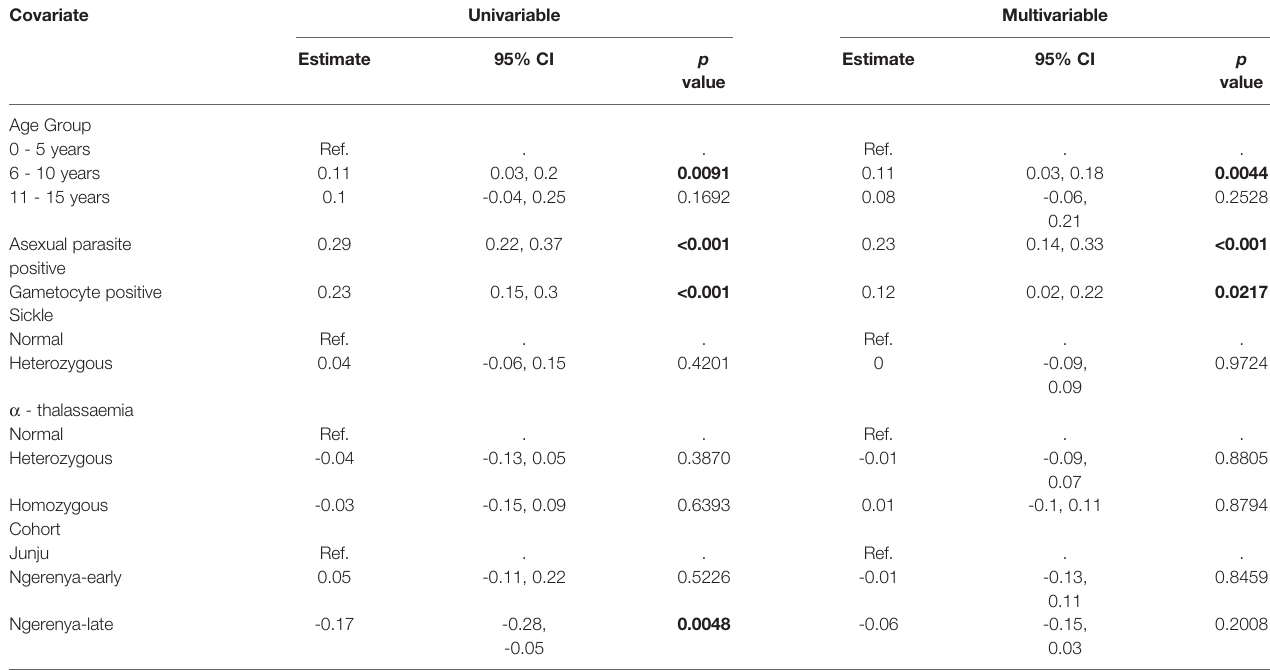
TABLE 5 | Linear regression analysis of the factors in fl uencing the number of antigens recognized by the study participants – KMLC cohort. Covariate Univariable Multivariable Estimate 95% CI p Estimate 95% value